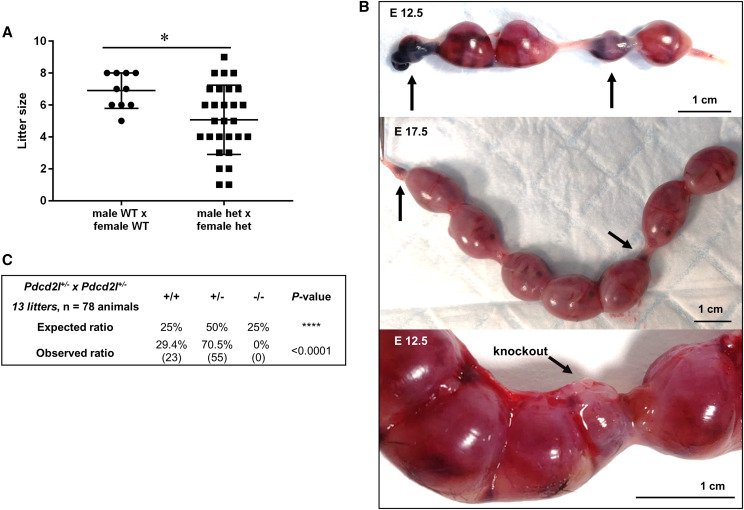
Loss of Pdcd2l causes embryonic death in mice. A) Litter sizes of wildtype and heterozygous matings. B) Embryo resorptions in mouse uteri from heterozygous Pdcd2l matings, at embryonic days [E] 12.5 and 17.5. Arrows point to embryo resorptions and in the bottom panel indicate a small embryo that was genotyped as a knockout. C) Analysis of genotype ratios from heterozygous matings in comparison to the anticipated Mendelian inheritance of 1:2:1 wildtype:heterozygous:knockout pups.